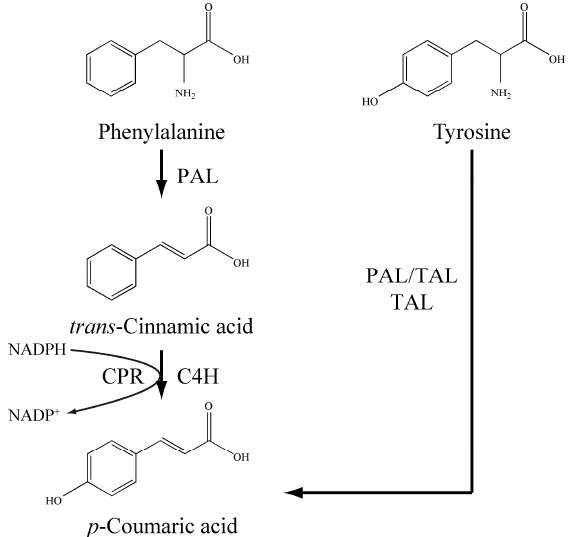
Figure 1. The biosynthetic routes of p ‐ coumaric acid. The phenylalanine route (PAL ‐ C4H) presents ubiquitously in plants and the tyrosine route (PAL/TAL and TAL) exists in some microbes.